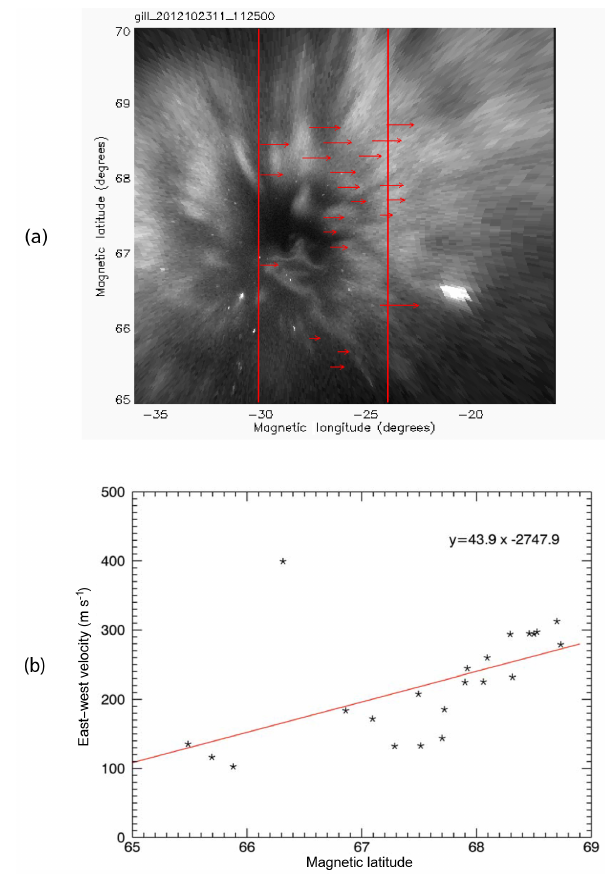
Figure 6. (a) An all-sky image at 11:25:00UT on 23 October 2012 in geomagnetic coordinates at Gillam station. Red vectors give the velocities of the patches (longitude from − 30 ◦ to − 24 ◦ ) during 11:10–11:30UT. The length of the vectors indicates the magnitude of the velocities. (b) Distribution of patch velocities with respect to magnetic latitude. The red line gives the linear fitting of all the